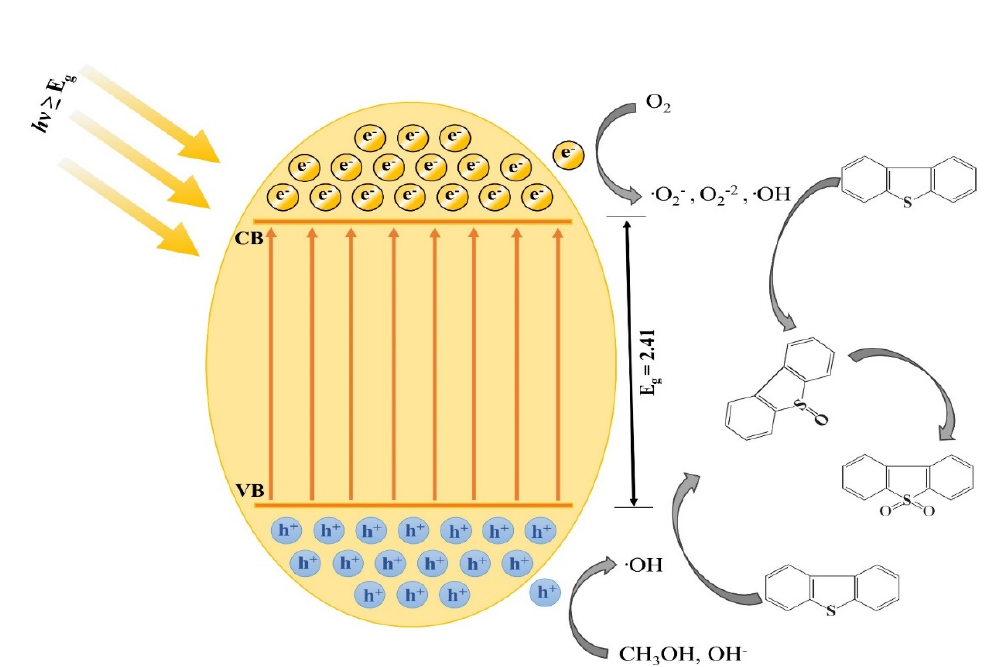
Figure 6. Proposed mechanism for photocatalytic desulfurization.